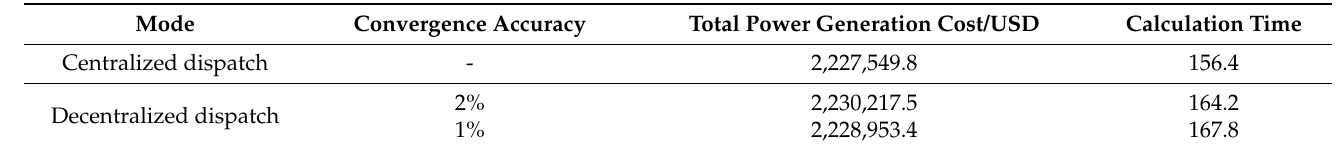
Table 6. Total power generation costs, convergence accuracy and calculation times of the system in two dispatch modes (two-region 78-node interconnected system).